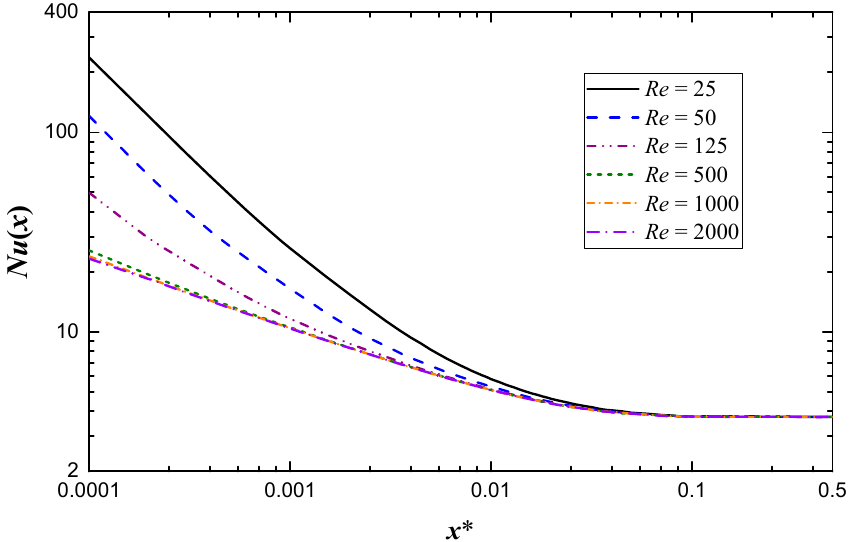
Figure 4. Local Nusselt number variation along the length of the channel with different Reynolds numbers for ε = 0.5.